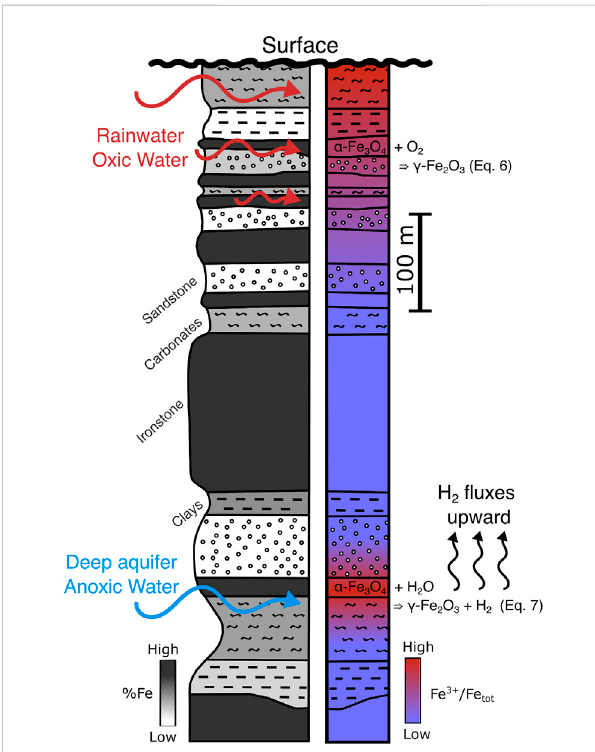
FIGURE 6 Schematic view of a late Archean BIF from Hamersley (Australia) and the related mineralogy, iron content, and iron speciation depending on the depth. In BIF, maghemite ( γ -Fe 2 O 3 ) grows during magnetite ( α -Fe 3 O 4 ) alteration by oxic water at the surface. We propose here a second process at depth: The alteration of magnetite by anoxic water that leads to the generation of H 2